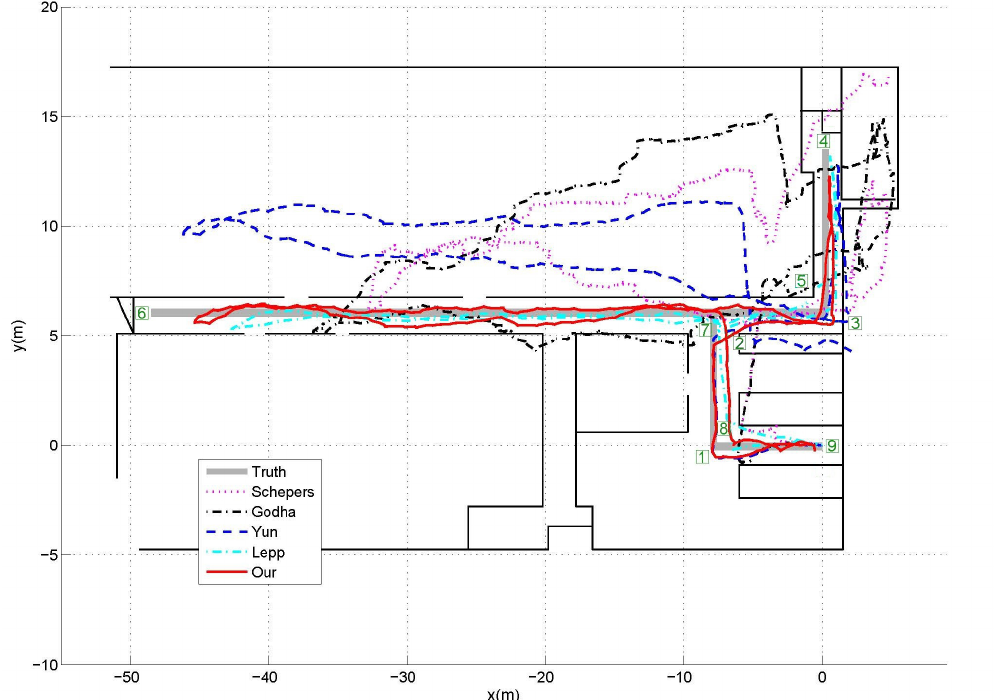
Figure 4. One example of the position estimation results for indoor experiments. Total walking distance was 132 m, at a speed about 0.75 m/s. The actual positions of the 9 critical points were marked by the square number plates. It is obvious that the integration of ZUPT and map information can improve the position estimation accuracy